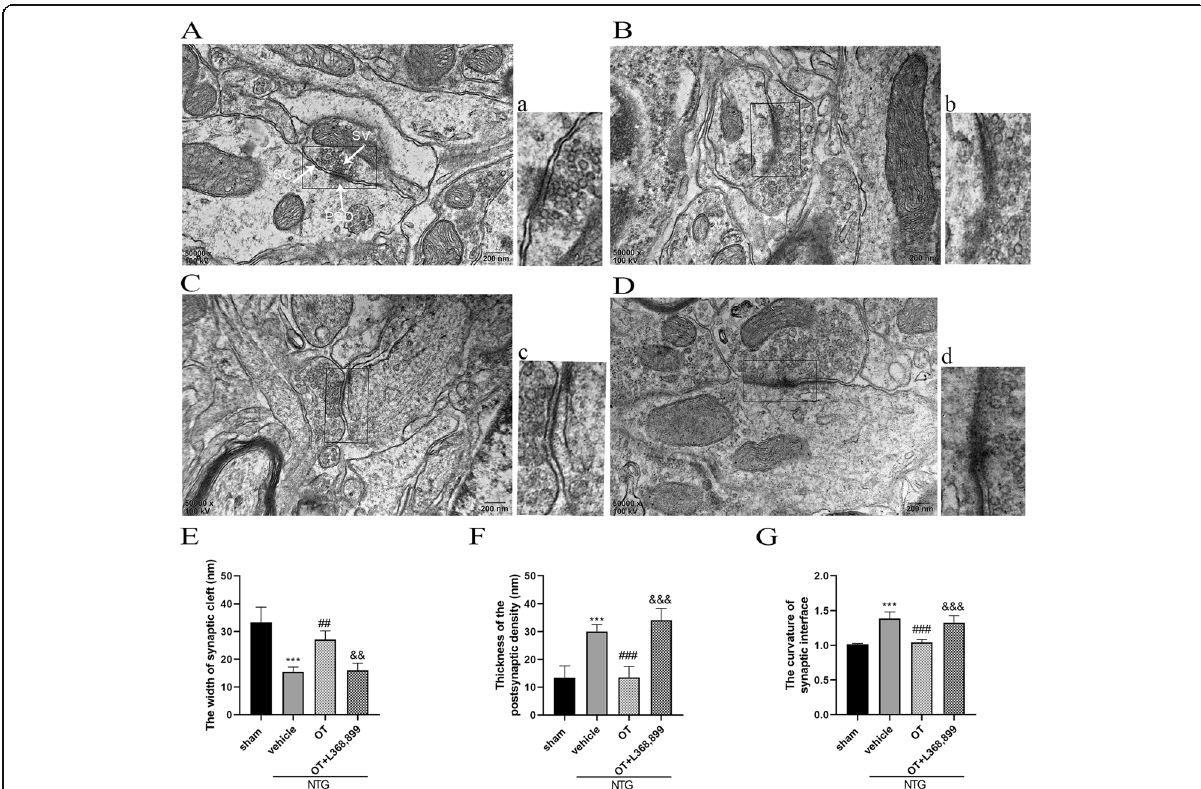
Fig. 7 Representative images and quantitative analysis of the synaptic ultrastructure in the TNC. A and a show the sham group, B and b show the NTG + vehicle group, C and c show the NTG + OT group, D and d show the NTG + OT + L368,899 group. a - d Magnification of the rectangle frame from each group was used to quantify parameters of the synaptic interface in the four groups. The width of the synaptic cleft ( E ) was decreased, and the thickness of PSD ( F ) and the synaptic interface curvature ( G ) were significantly increased in the NTG + vehicle group compared to the sham group. In the NTG + OT group, these abnormal alterations were alleviated. The morphological parameters in the NTG + OT + L368,899 group were similar to those in the NTG + vehicle group. One-way ANOVA with Dunnett ’ s post hoc test, n = 4/group; ** p < 0.01, *** p < 0.001 vs. the sham group; ## p < 0.01, ### p < 0.001 vs. the NTG + vehicle group; && p < 0.01, &&& p < 0.001 vs. the NTG + OT group; scale bars: 200 nm; PSD, postsynaptic density; SC, synaptic cleft; SV, synaptic